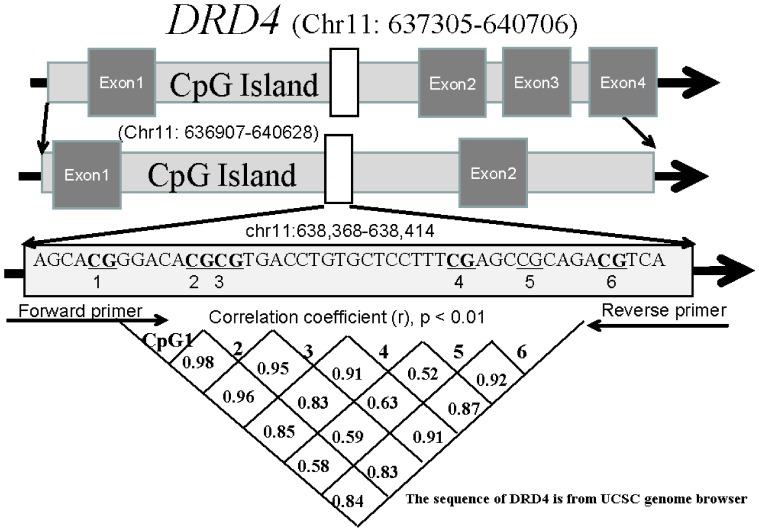
Significant methylation correlation of 6 CpG sites on DRD4 CpG islandsa.a: The hg19 version from UCSC genome browser was used for the genomic positions.